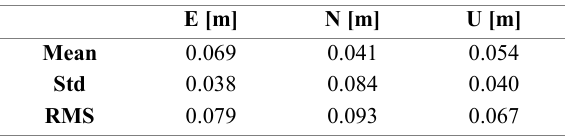
Table 3. Statistics of the differences between the photogrammetric CPC and the coordinates of APC+ L w after